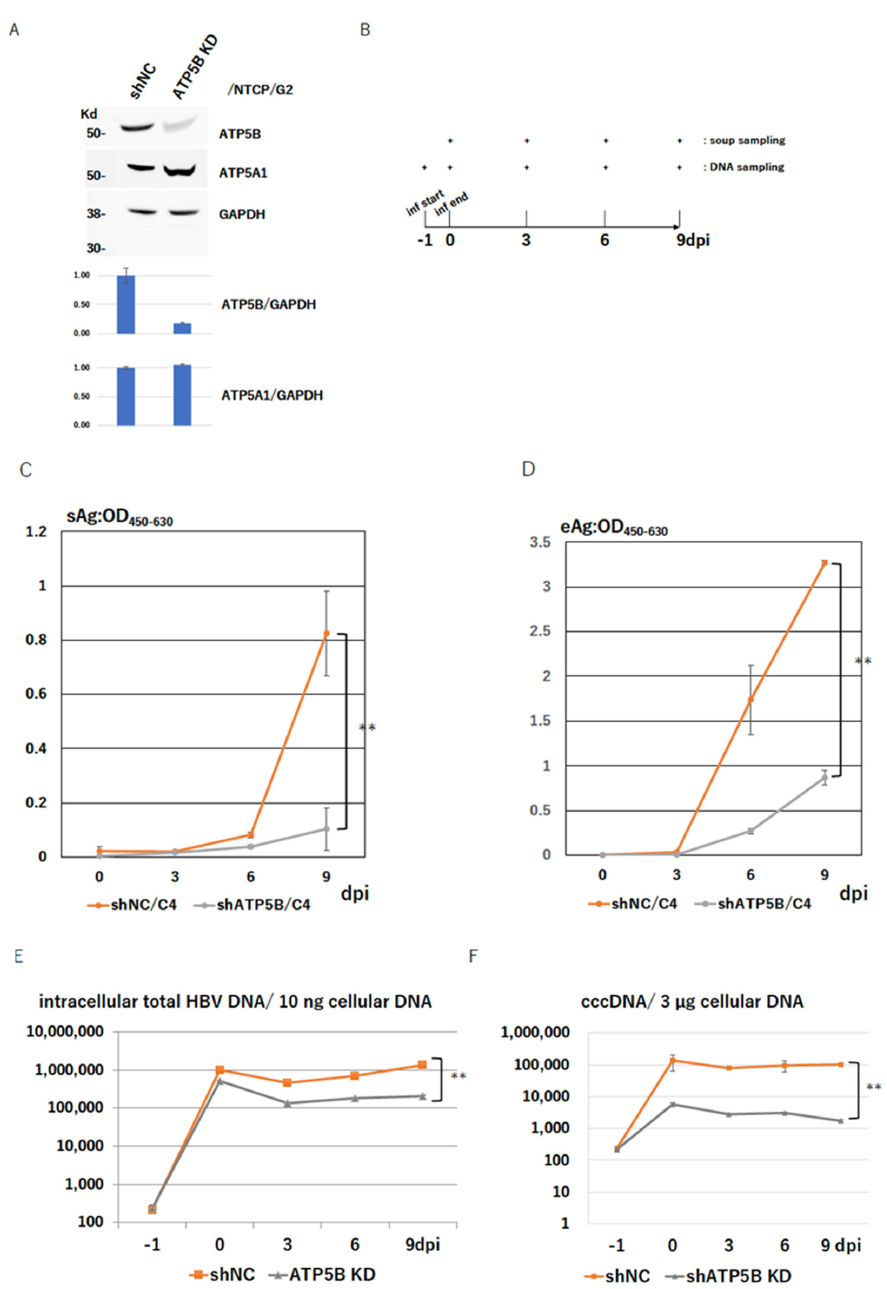
Figure 3. Low efficiency of HBV infection to ATP5B − knocked down cells. ( A ) Establishment of ATP5B cells in NTCP − expressing HepG2 cells. ATP5B and ATP5A1 expression levels were